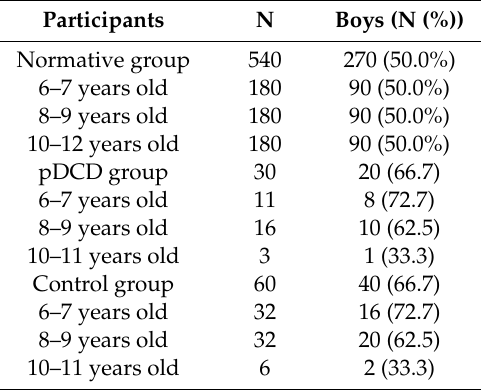
Table A1. Age and sex for all groups ( n =